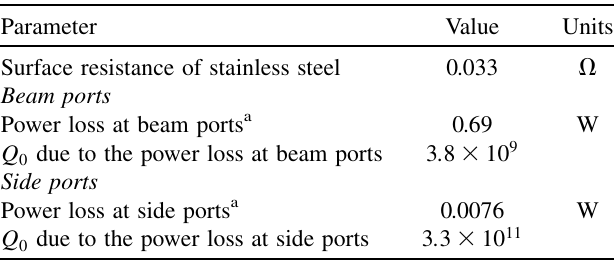
TABLE II. Port losses at beam and coupler ports. Parameter Surface resistance of stainless steel Beam ports Power loss at beam ports a Side